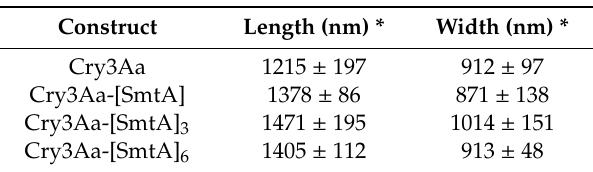
Table 1. The mean length and width of Cry3Aa and Cry3Aa-SmtA fusion crystals based on scanning electron microscopy (SEM)